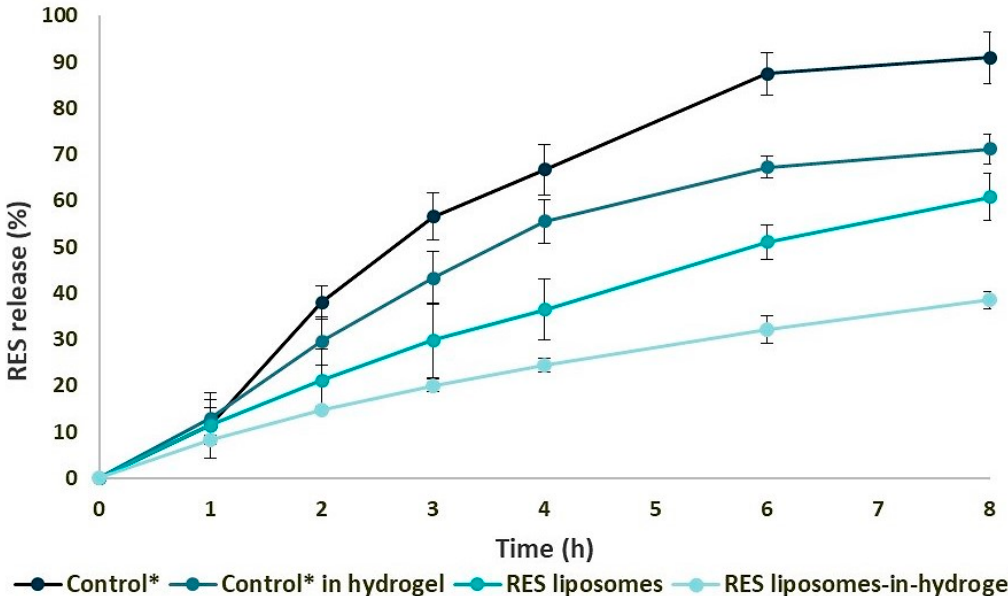
Figure 1. Sustained in vitro resveratrol (RES) release ( n = 3). RES release from liposomes and liposomes-in-hydrogel compared to the respective controls, assessed by a spiral release system for 8 h. Results are expressed as percentage mean ± SD. * RES in propylene glycol.